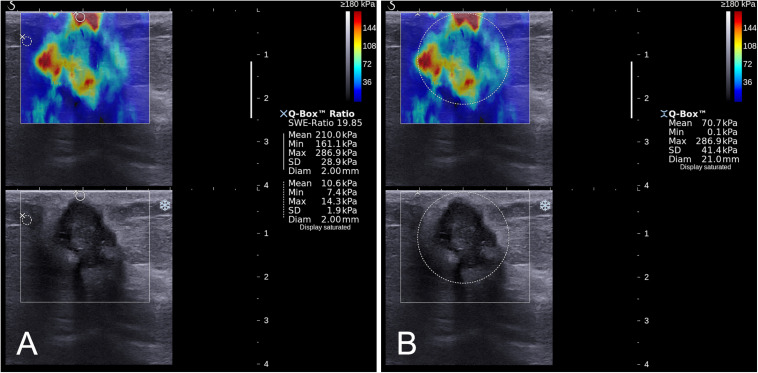
Images show a grade 3 invasive ductal carcinoma in a 67-year-old woman. A standardized rectangular region of interest (ROI) was set for shear-wave elastography (SWE) image acquisition, and stiffness was displayed as a color map in the rectangular ROI (A,B). Quantitative SWE parameters including Emax (286.9 kPa), Emean (210.0 kPa), and Eratio (19.85) were measured by using two 2-mm2 round ROIs. One was placed within or adjacent to the mass to encompass the maximum stiffness area, and the other one placed at the normal fatty tissue outside the lesion, but within the square ROI (A). Another round ROI adjusted to the mass contour to encompass the maximum area of mass was used to measure ESD (41.4 kPa; (B)).